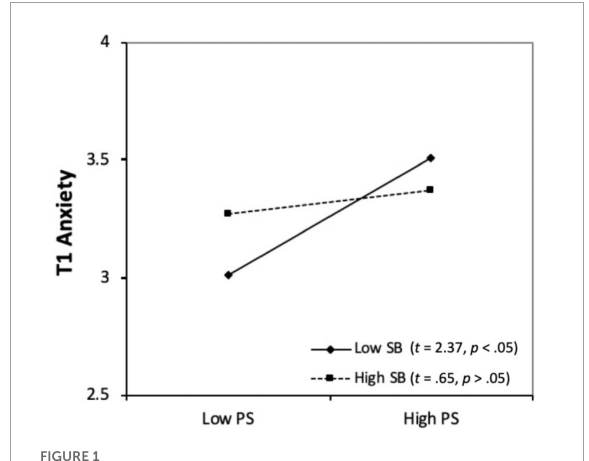
FIGURE1 Social-behavior strategy as a moderator between performance self-talk and T1 Anxiety. PS, performance self-talk; SB,